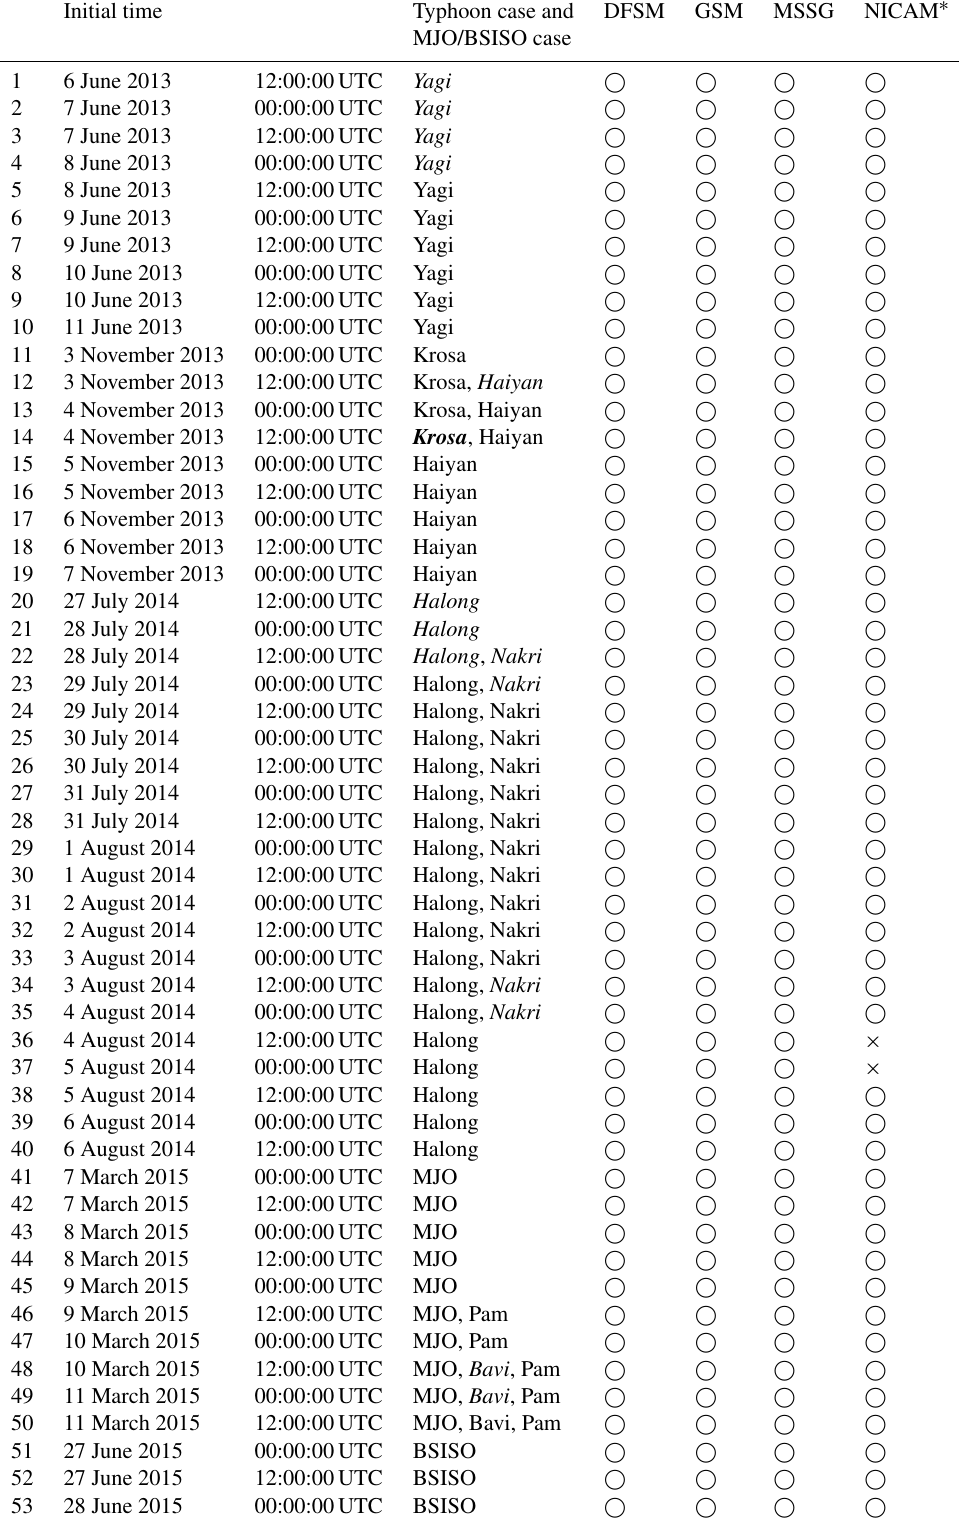
Table 2. List of initial times for stage 2 of TYMIP-G7. Typhoon cases in italic font are weaker than a tropical storm and those in bold italic font are extratropical